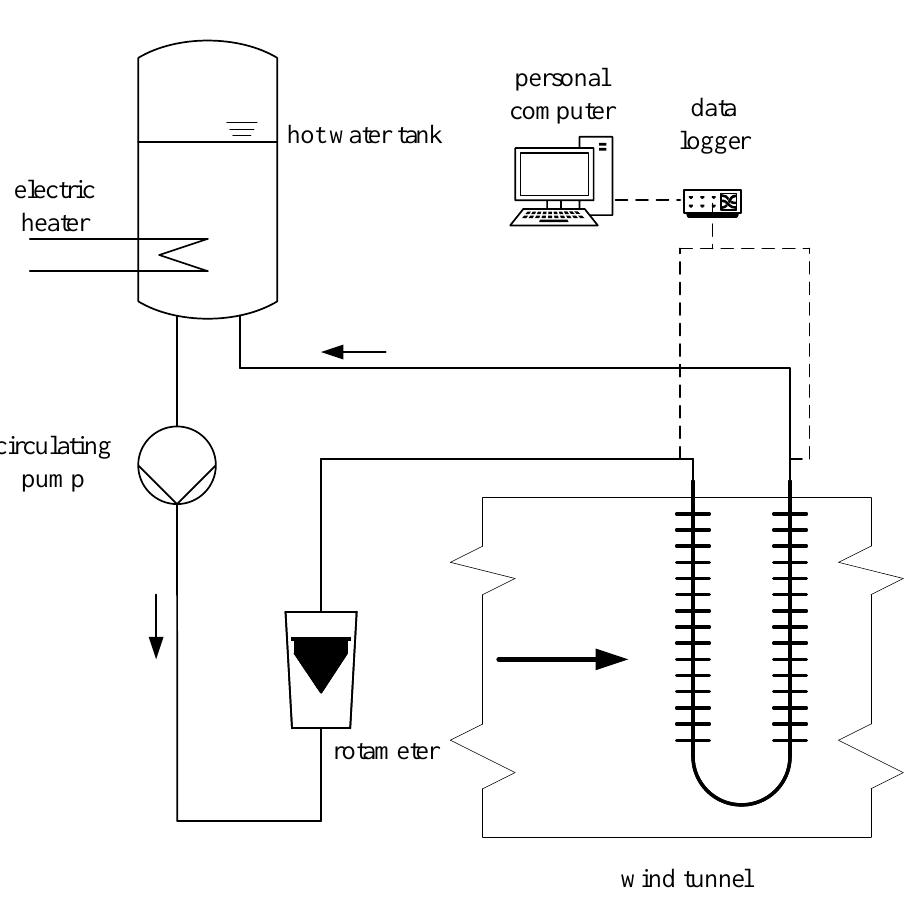
Figure 2. Experimental